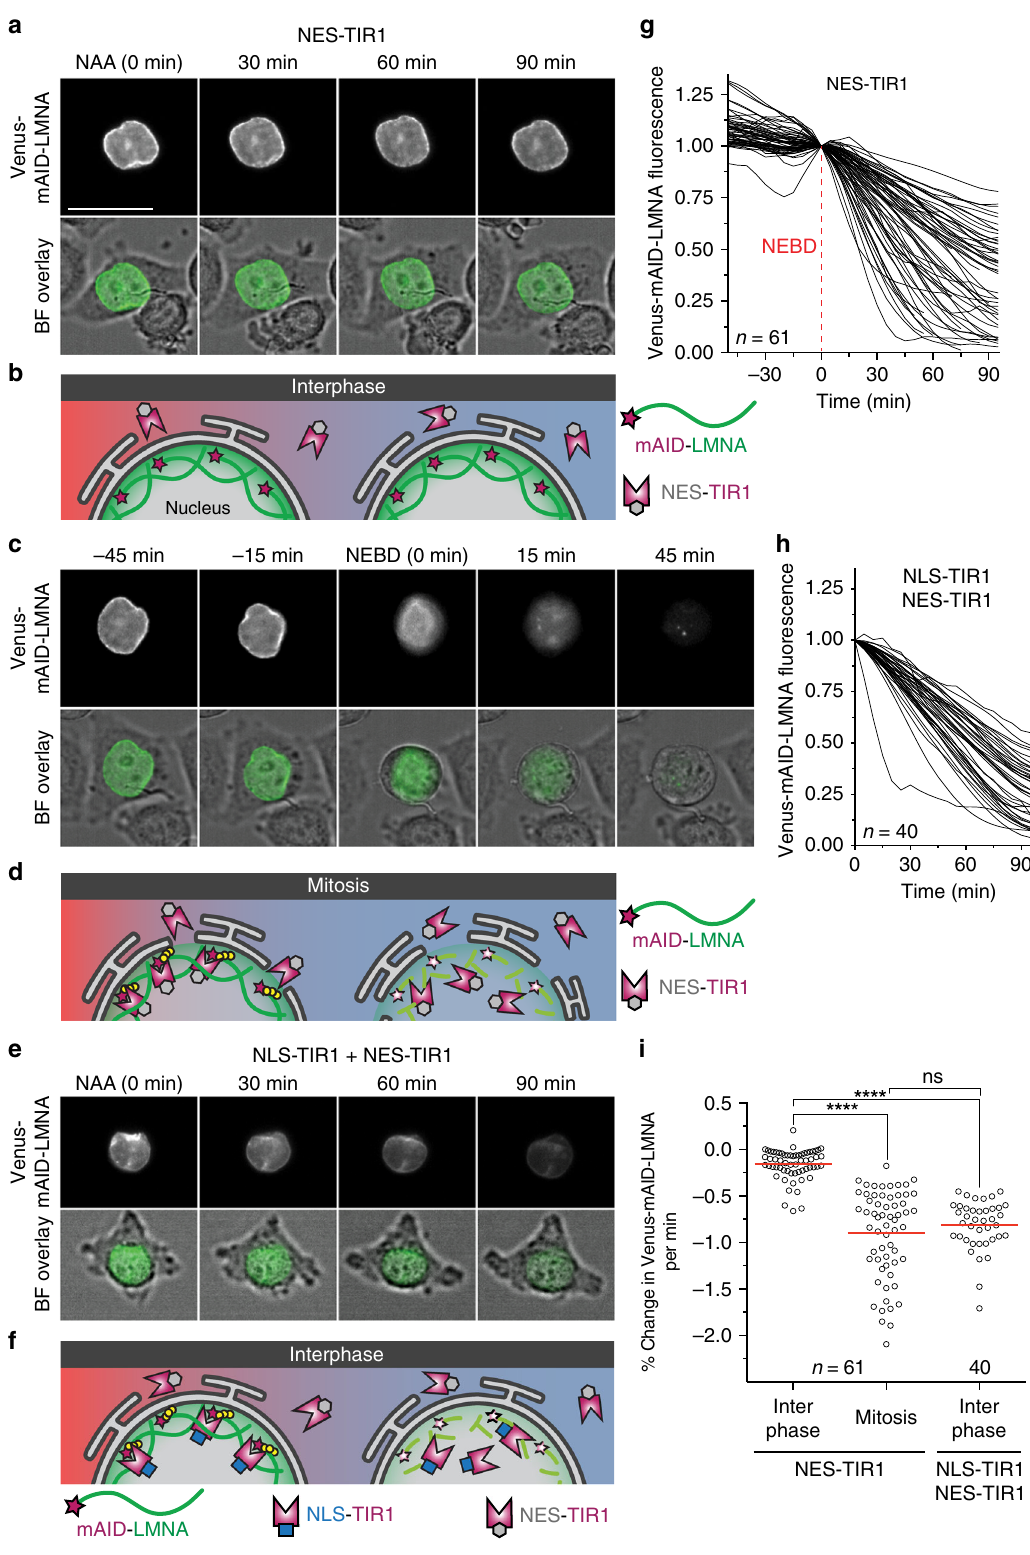
found that although the ZF1-tagged reporter degraded, the reporter without the degron did not show signi fi cant changes in comparison to a strain that did not express any degron-tagged reporter (Supplementary Fig. 4). Thus, degron tagging does not generally lead to degradation of protein